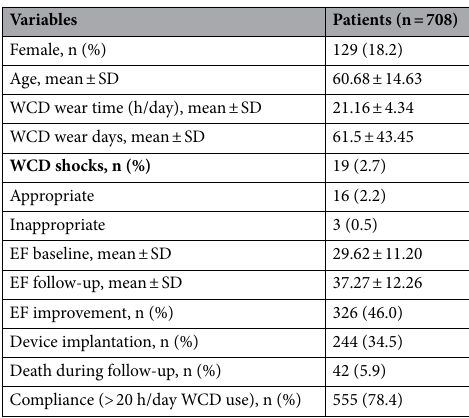
Table 1. Baseline characteristics of 708 patients with WCD